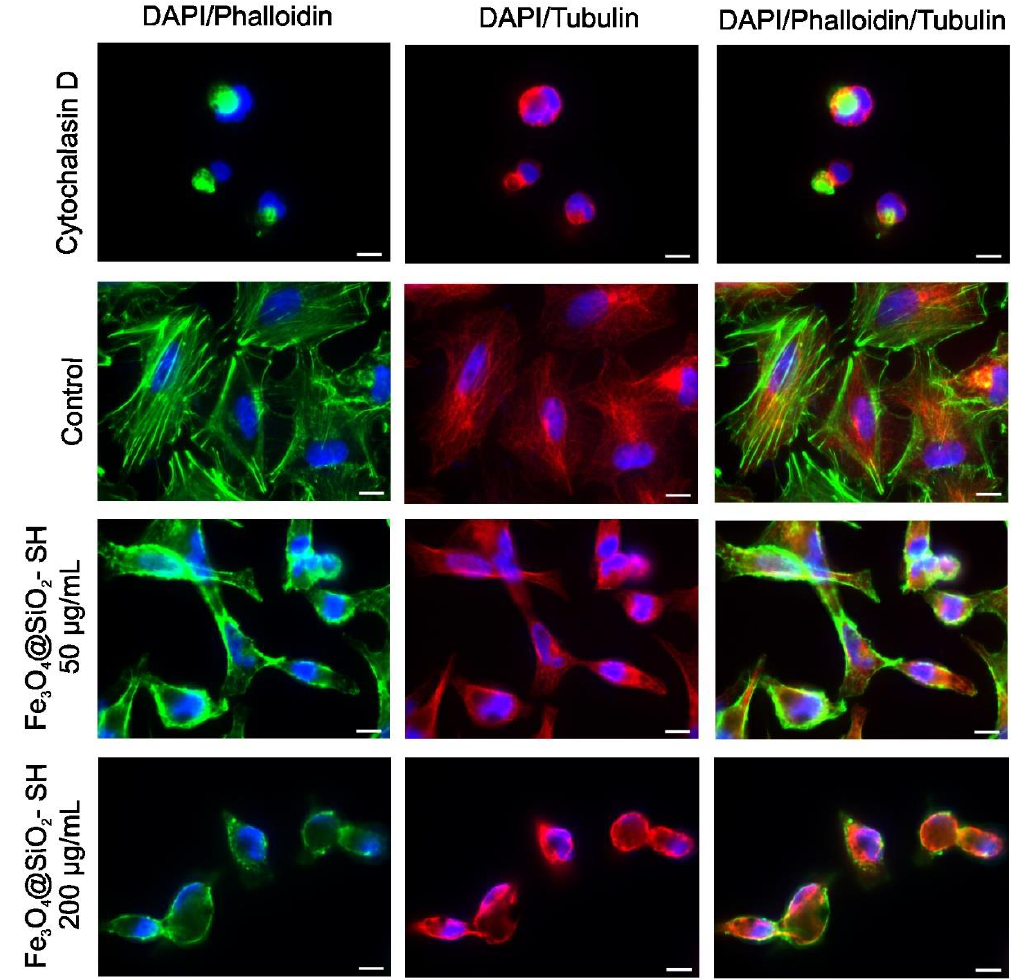
Figure 8. Fluorescent microscopic images of A549 cells stained with Alexa Fluor 488 phalloidin (F-actin, green) and anti- β -tubulin antibody (red), and counterstained with 4 ′ ,6-diamidino-2-phenylindole ((DAPI), nuclei, blue). The cells were sham-treated with H 2 O (negative control) or treated Fe 3 O 4 @SiO 2 -SH nanoparticles at 50 and 200 µg/mL. Cells treated with 0.5 µg/mL of cytochalasin D, a member of the cytochalasin fungal alkaloids that acts as a potent inhibitor of actin polymerization, were used as a reference in this assay. Experiments were performed in triplicates, but only photographs from representative chambers are shown. The scale bar in the images represents 10 μm.